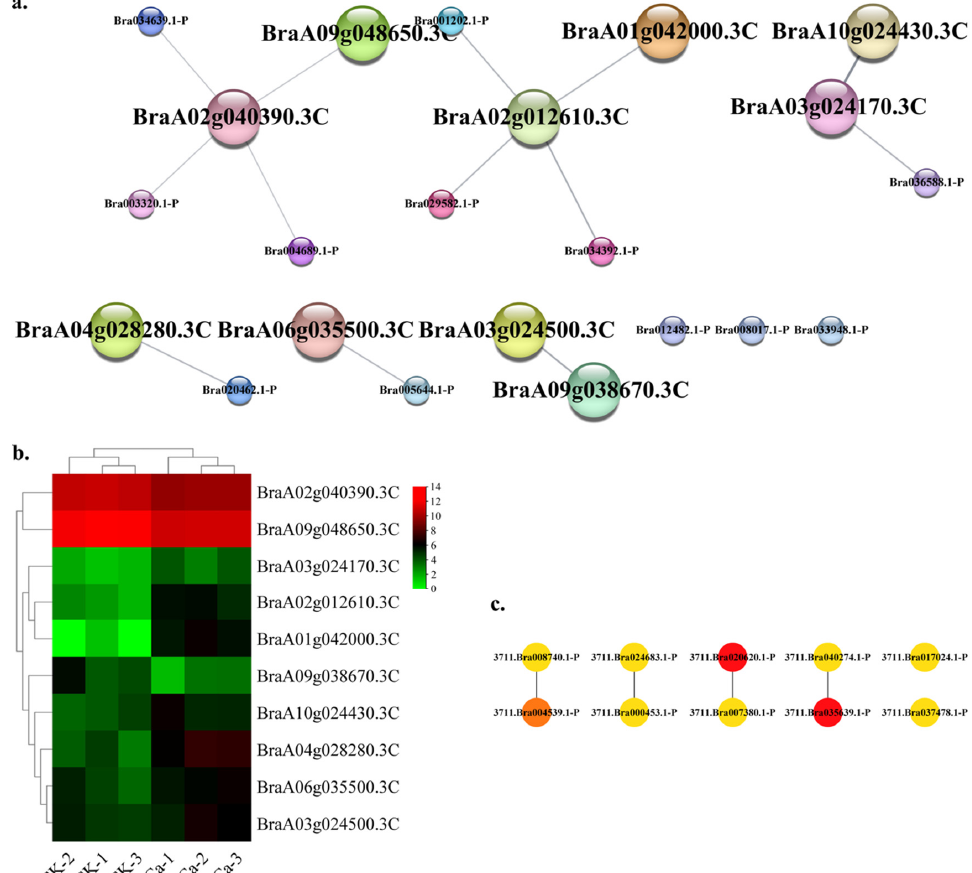
Figure 13. Protein–protein interaction (PPI) analysis in transcription factor (TF)-related DEGs category. ( a ) PPI network in the TF category. ( b ) Heatmap of the hub gene expression pattern. ( c ) Hub genes’ interactive relationship of the gene regulatory network.